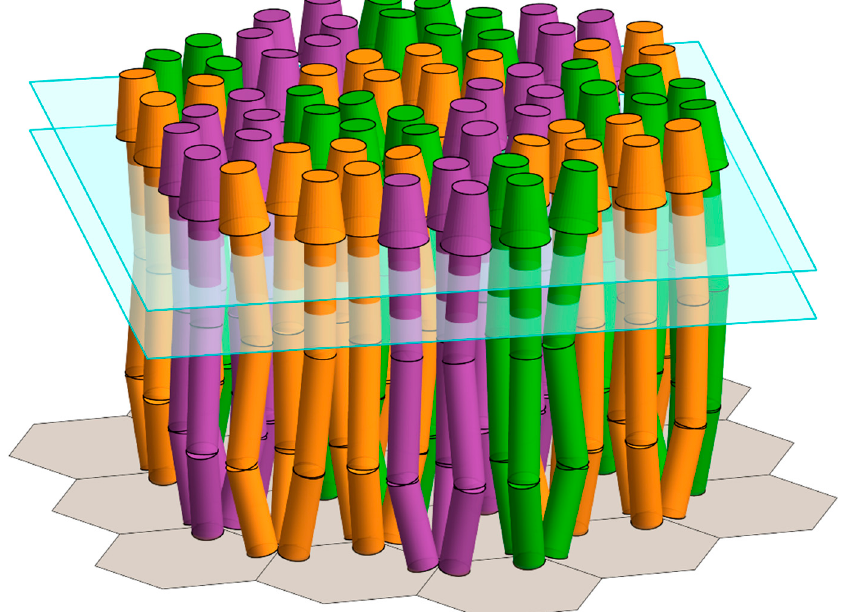
Figure 7. Model of an array of core signaling complexes with heterologous chemoreceptor deflection angles at the HAMP and Gly hinges. The model is an expanded version of the upper right-hand panel in Figure 2B. As in that panel, the dimensions and the angles are those for E. coli , and bent chemoreceptor dimers fit into the available space. Different from that panel, the deflection angles at each of the two flexible hinges for each receptor dimer are variable.